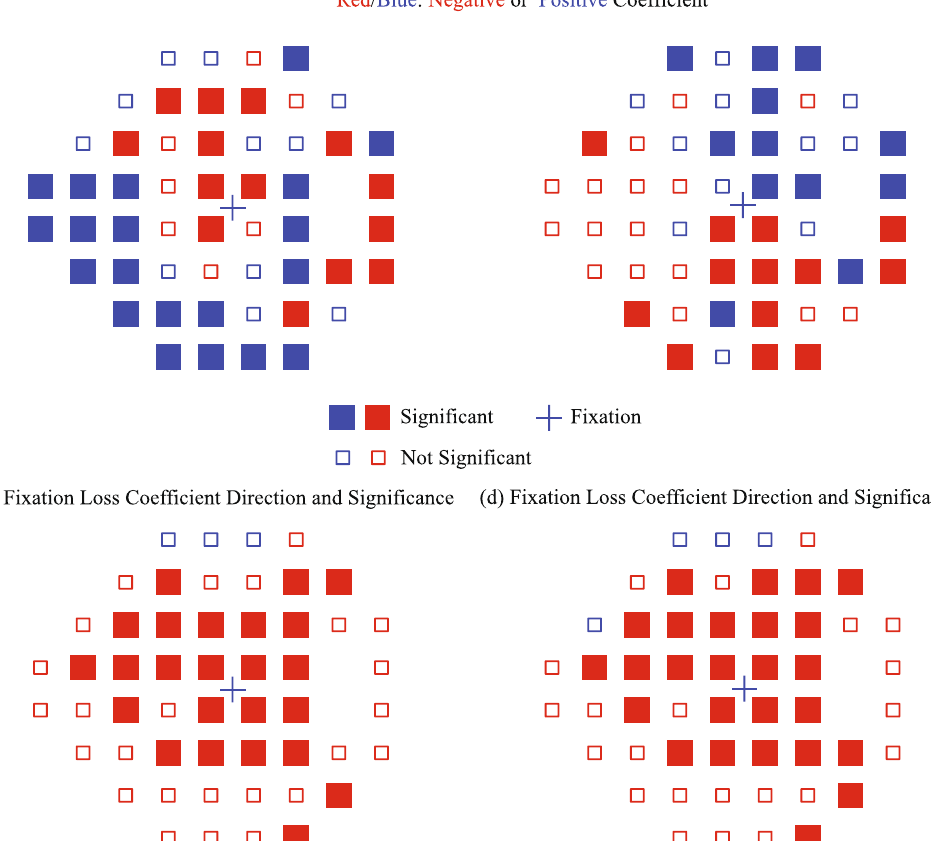
Figure 5. Multivariate linear regression from NBSL distance/angle and fixation loss rate to PD values: ( a ) the NBSL distance coefficient sign and ( b ) the fixation loss coefficient sign for each VF testing locations from the linear regression with NBSL distance and fixation loss rate; ( c ) the NBSL angle coefficient sign and ( d ) the fixation loss coefficient sign for each VF testing locations from the linear regression with NBSL angle and fixation loss rate. P-values less than 0.05 after multiple comparison correction with false discovery rate were considered as